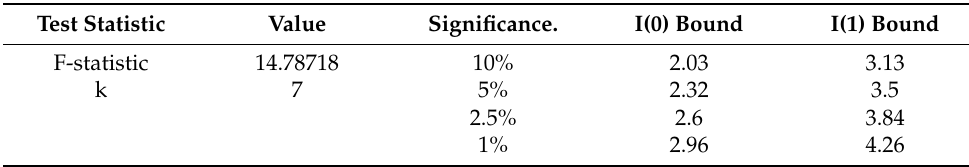
Table 6. Results of ARDL Bounds